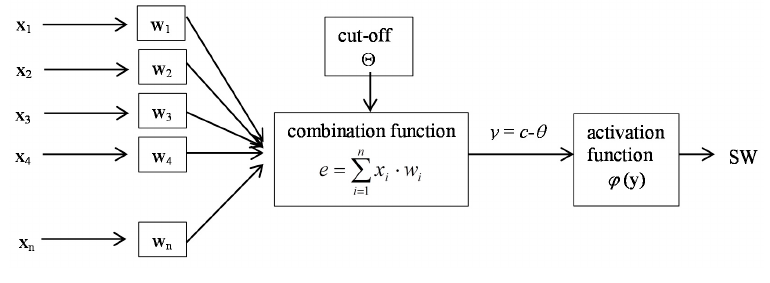
Figure 2. Neural network model.